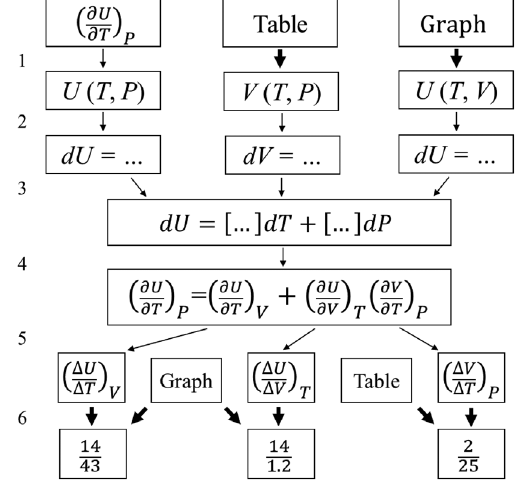
FIG. 7. An analytical derivation strategy — the differentials method. This strategy involves translation, consolidation, and